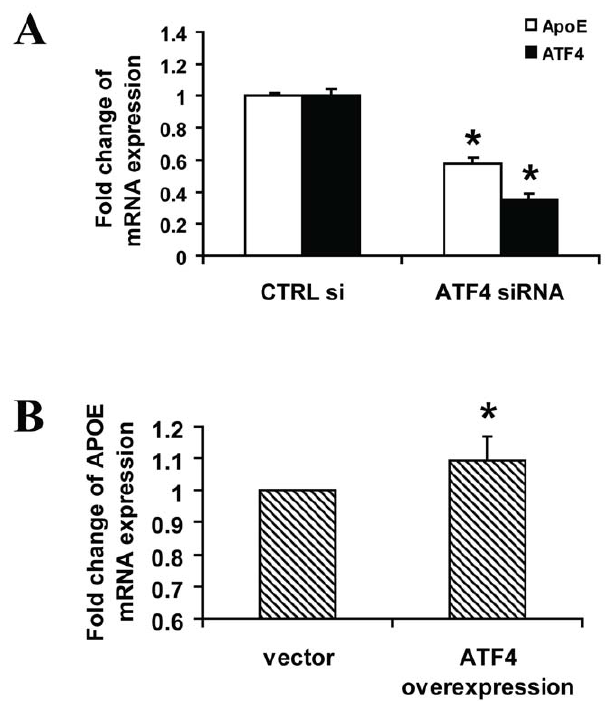
Figure 4. ATF4 modulates endogenous APOE expression. (A) WRL-68 cells were transfected with 100 pmol of ATF4 siRNA or control siRNA. The expression levels of APOE and ATF4 were measured by Q- PCR after normalizing to beta-actin. Q-PCR data of cells treated with control siRNA were set as 1. (B) WRL-68 cells were transfected with 1 m g of pcDNA3.1-ATF4 mammalian expression vector (or pcDNA3.1 empty vector). Results are presented as the fold change of endogenous APOE mRNA expression relative to that of the cells transfected with pcDNA3.1 vector controls (value set at 1). Data shown are from 3–4 independent experiments in triplicate set-up, * p , 0.05.